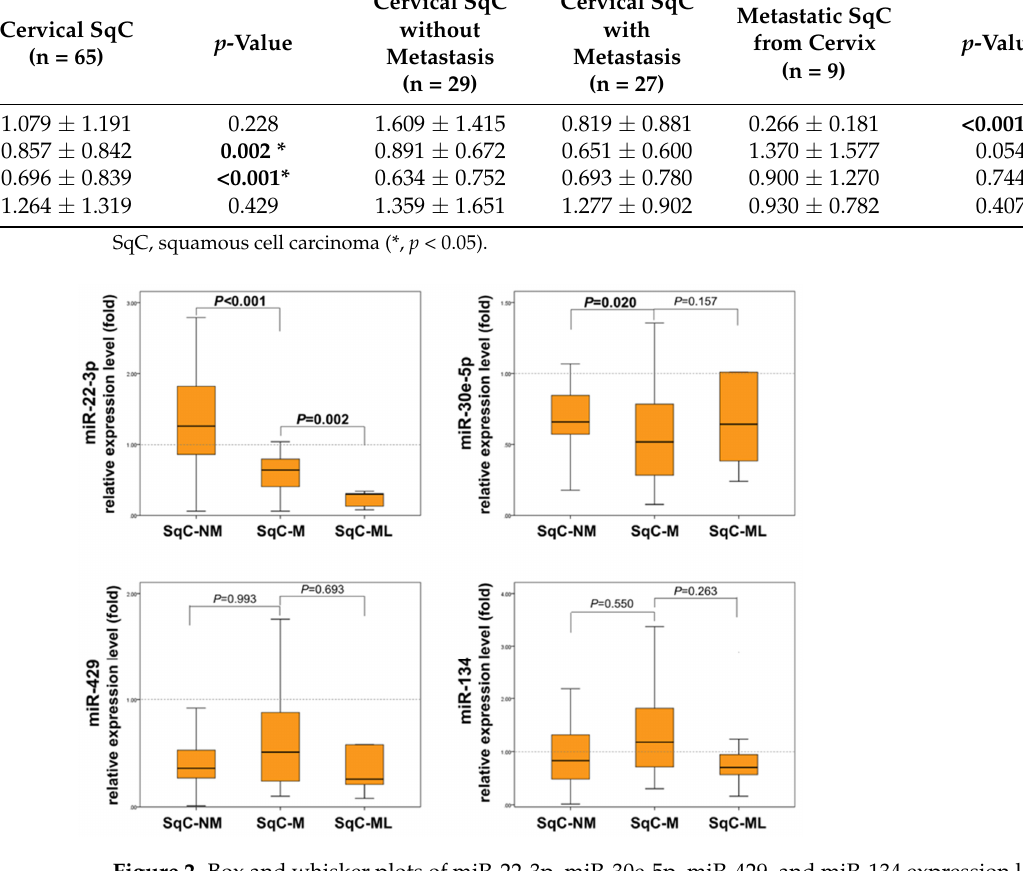
Figure 2. Box and whisker plots of miR-22-3p, miR-30e-5p, miR-429, and miR-134 expression levels in primary cervical SqCC without metastasis (SqC-NM; n = 29), primary cervical SqCC with metas- tasis (SqC-M; n = 27), and metastatic lesions from cervical SqCC (SqC-ML; n = 9) relative to the level